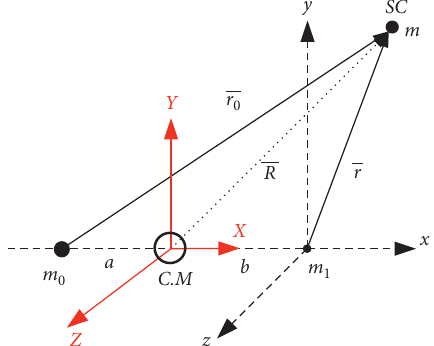
Figure 1: The kinematics of circular planer three